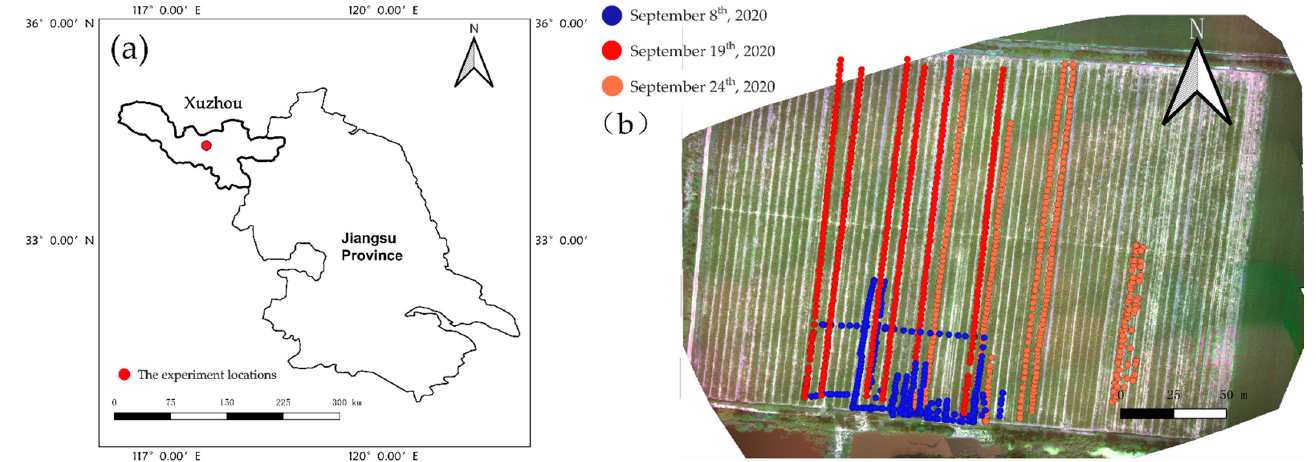
Figure 1. ( a ) The study area located in Xuzhou and the experimental field; ( b ) images of the experi- mental field obtained on 8, 9, and 24 September 2020 using a low-altitude UAV equipped with an RGB sensor. Each of the colors represents a different experiment date. Each drone image has its own coordinate.